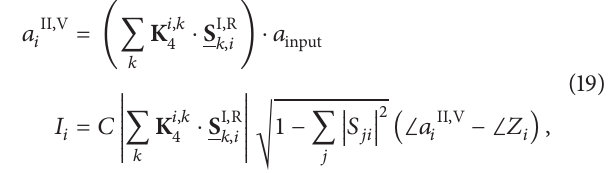
with the home-made hybrid genetic algorithm; (2) the H- arm, port-1, and port-2 are coplanerly placed on the top layer, while the E-arm is placed on the bottom layer to decrease the intensive coupling effects with other ports, as shown in Figure 3. The equivalent circuit and decomposition circuit of the improved magic-T are shown in Figure 4. It was found that there are seven nonstandard interconnections (marked by circle lines), which are replaced by the three-port ILSRNs (numbered by 1-2-3, 4-5-6, 7-8-9, 18-19-20, 21-22-23, 40-41- 42, and 43-44-45, resp.). Besides, there are two transformers (numbered by 14-15-16-17 and 58-59-60-61, resp.), an open end (numbered by 68), and a group of transmission